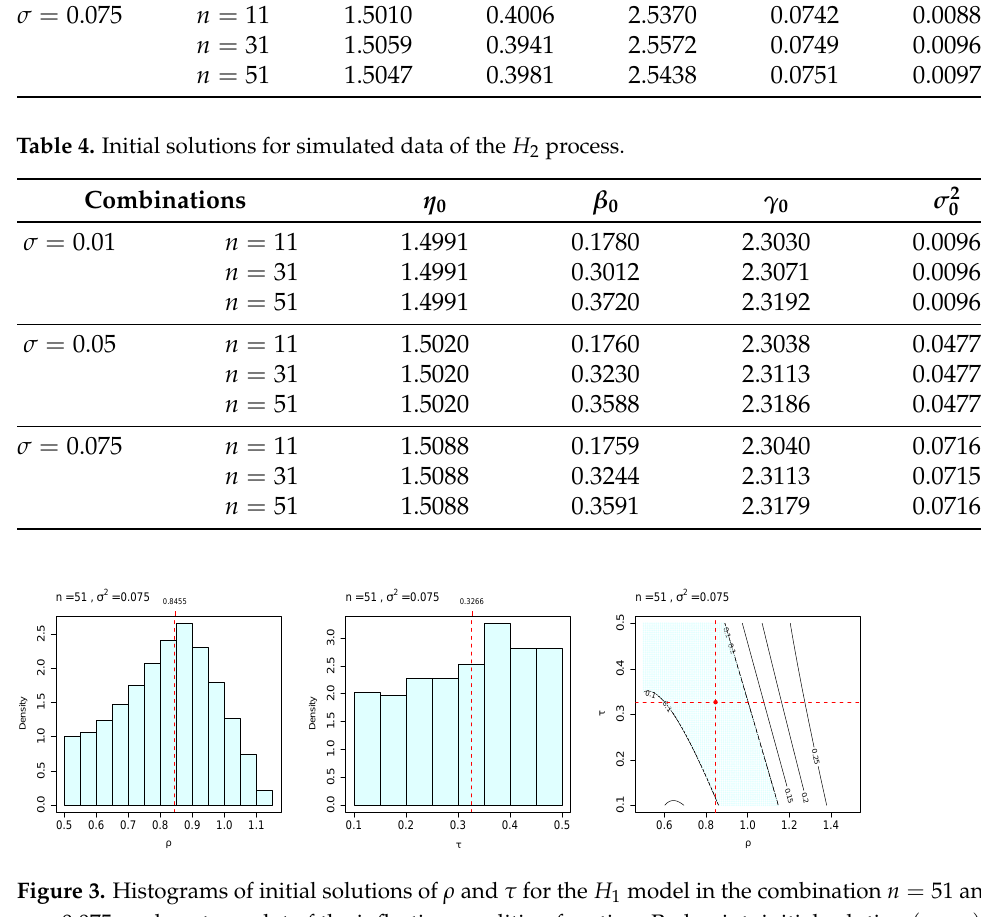
Figure 3. Histograms of initial solutions of ρ and τ for the H 1 model in the combination n = 51 and σ = 0.075, and contour plot of the inflection condition function. Red point: initial solution ( ρ 0 , τ 0 )